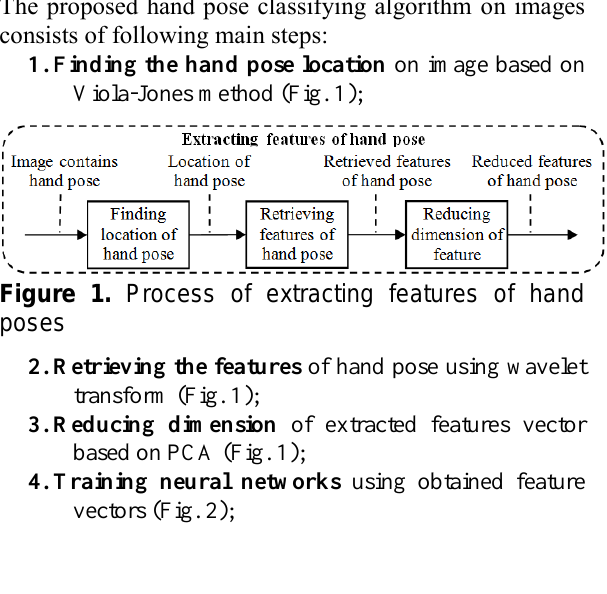
Figure 2. Process of training neural networks